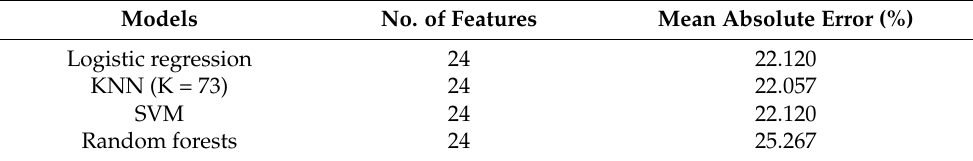
Table 3. Models without feature selection.